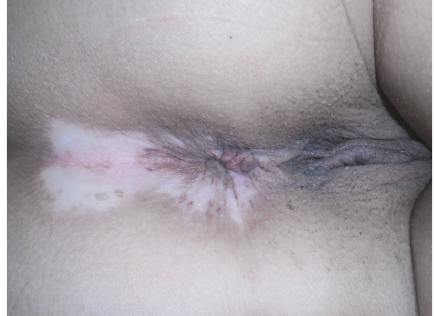
Figure 3: Perianal depigmented patch with